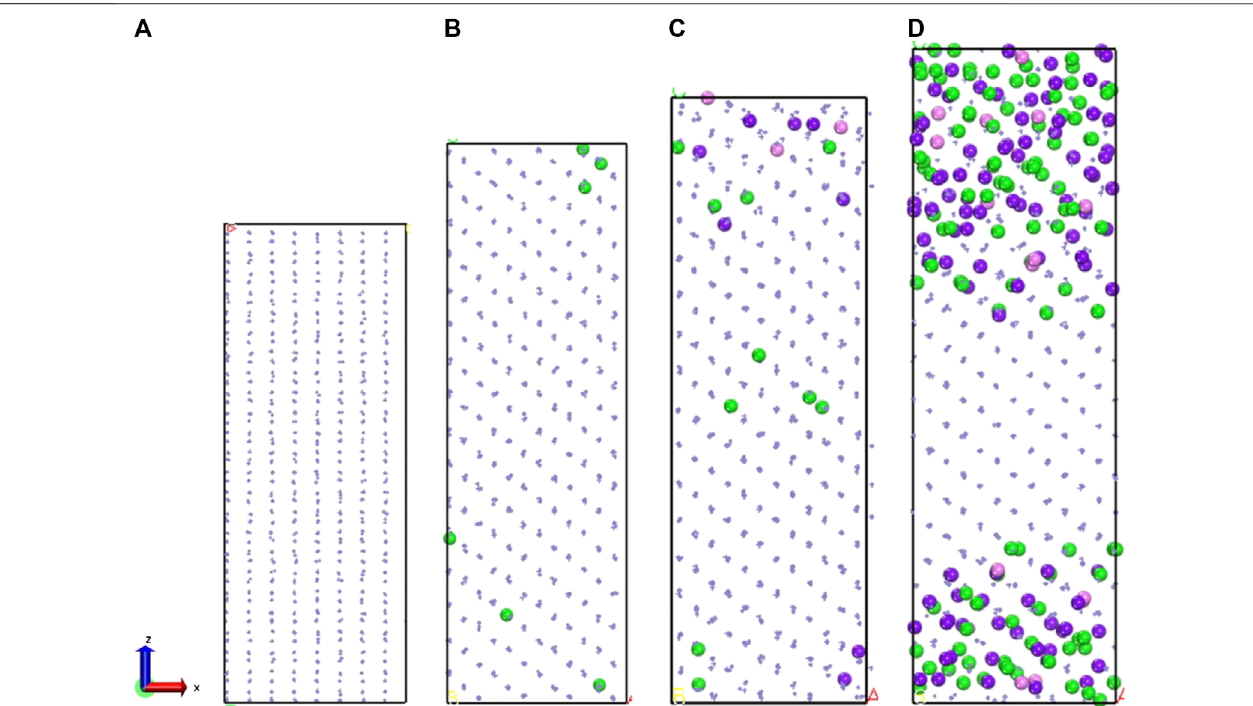
FIGURE 8 | Coordination – strain diagram of Fe atom in γ -Fe 2 O 3 structure.